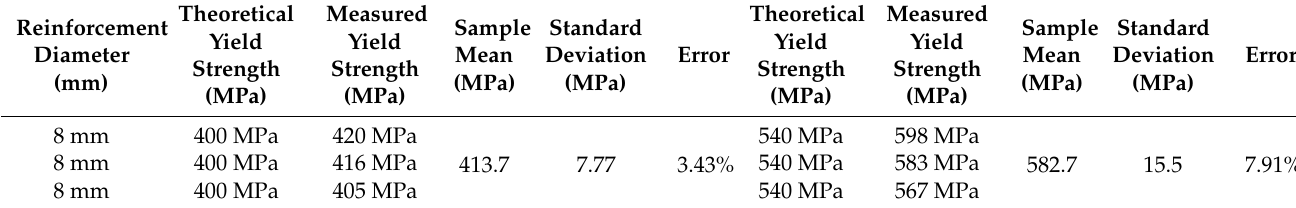
Table 3. Properties of steel bar